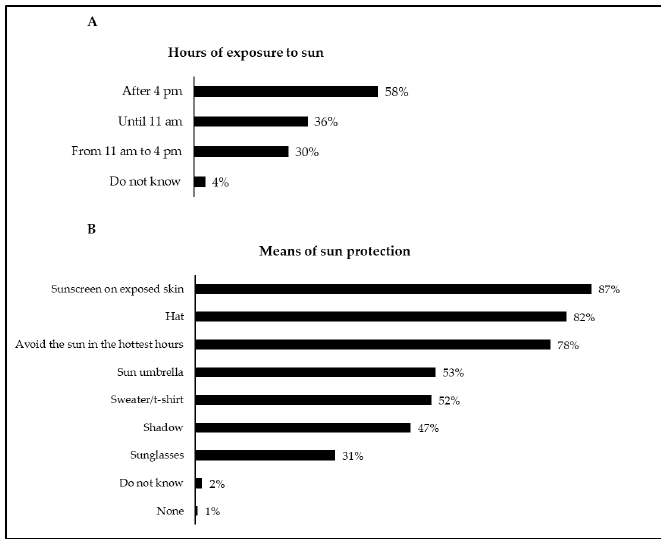
Figure 4. Hours of exposure to the sun ( A ) and means of sun protection ( B ) in the child/adolescent. In both figures, the sum of the proportions exceeds 100% because multiple-choice answers were allowed.